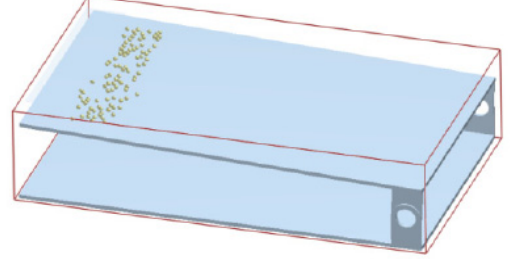
Figure 6. Soil slip simulation test [83].